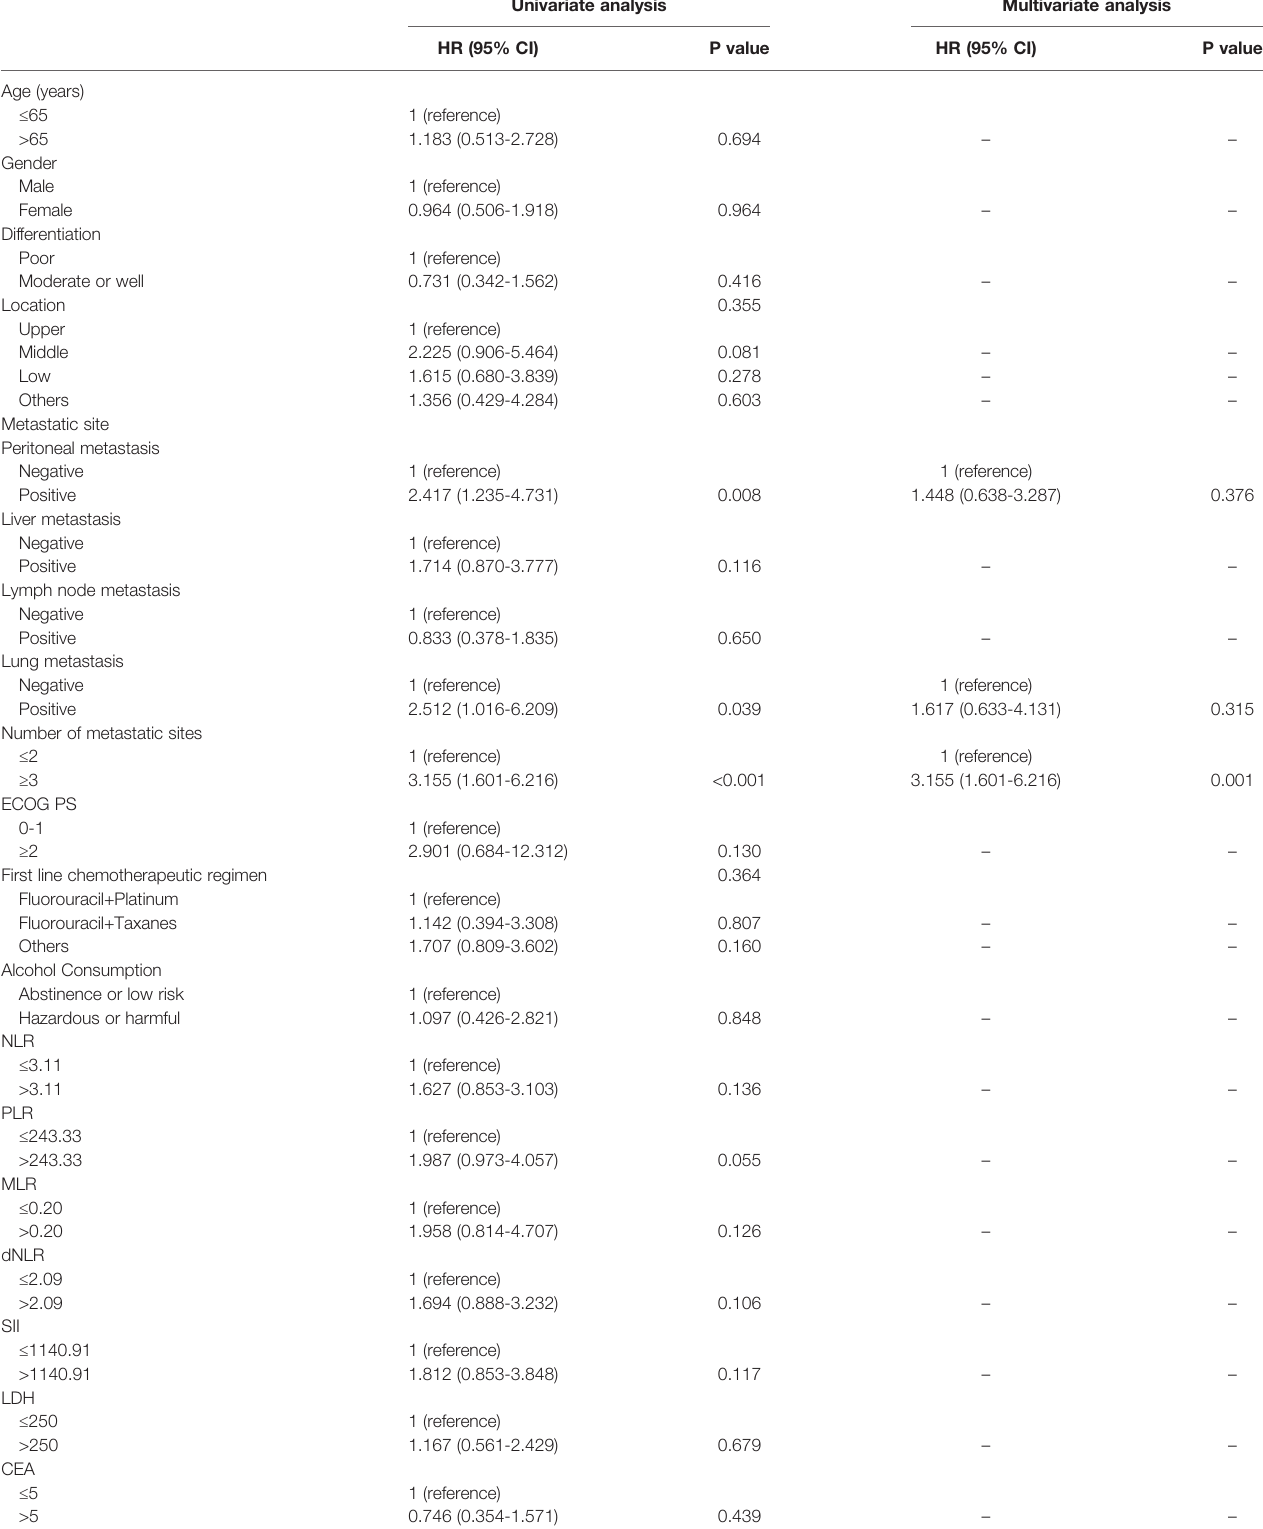
TABLE 2 | Univariate and multivariate analysis of factors according to PFS in AGC patients treated with anti-PD-1 drugs in the fi rst-line